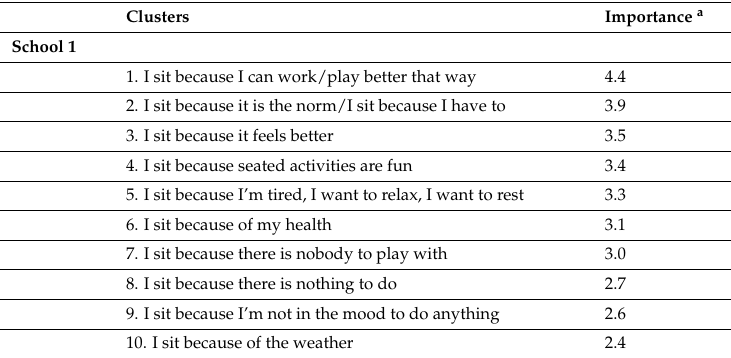
Table 1. Children’s clusters and average importance ratings.